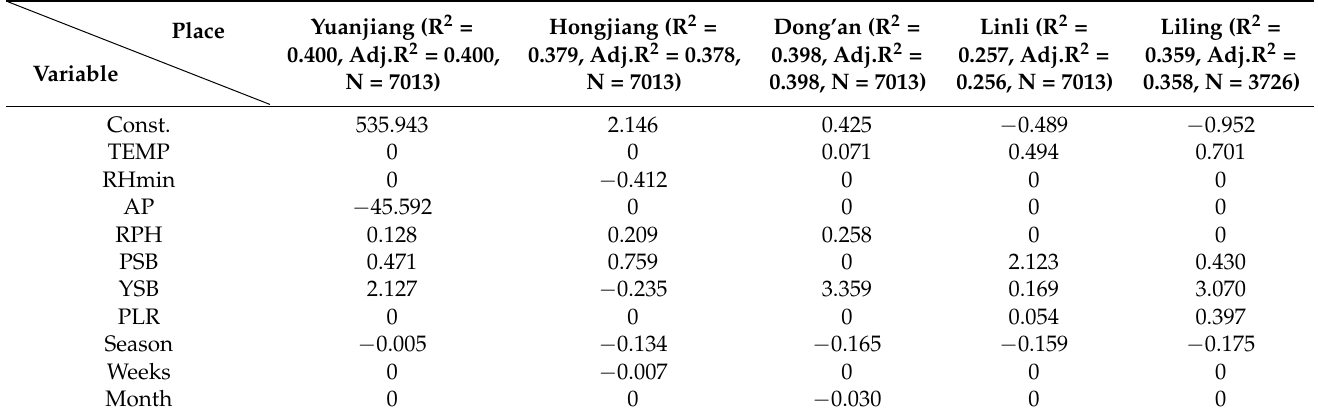
Table 8. Summary of the MLR model for the training datasets of each study area.